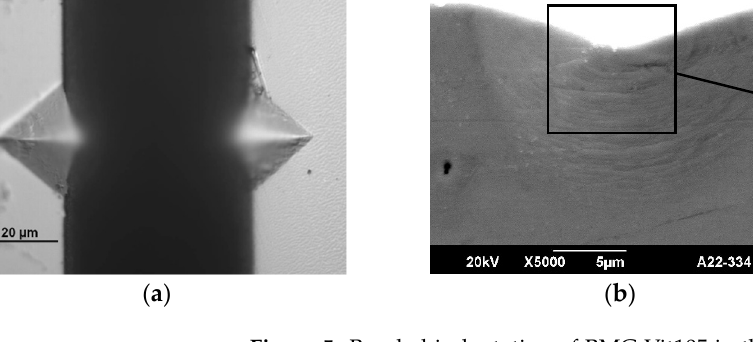
Figure 5. Bonded indentation of BMG Vit105 in the initial state fixed with a gasket: ( a ) top view; ( b ) deformation area on the side surface area near the indent (SEM); ( c ) same, en- larged.